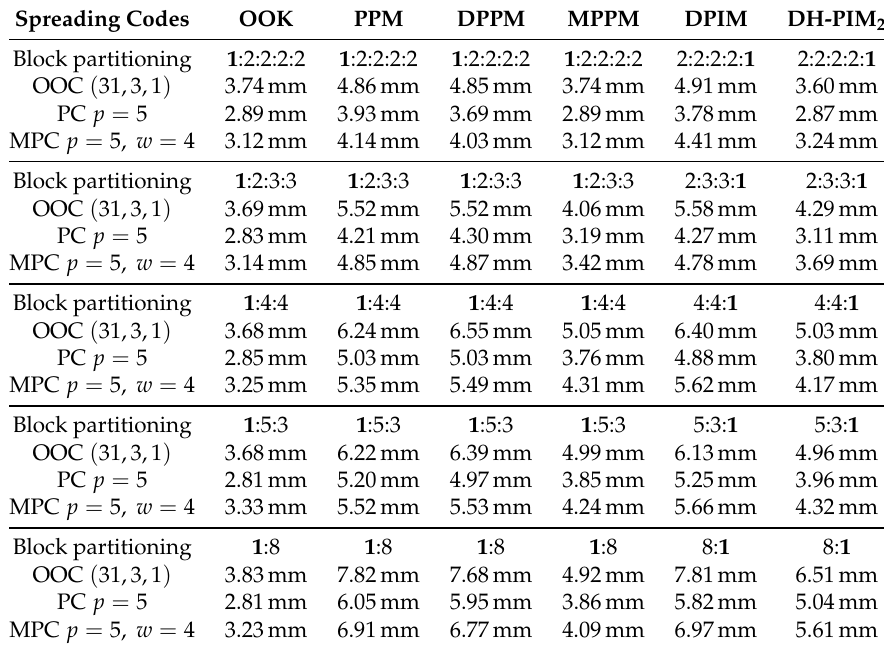
Table 16. Precision as a combination of modulation and spreading